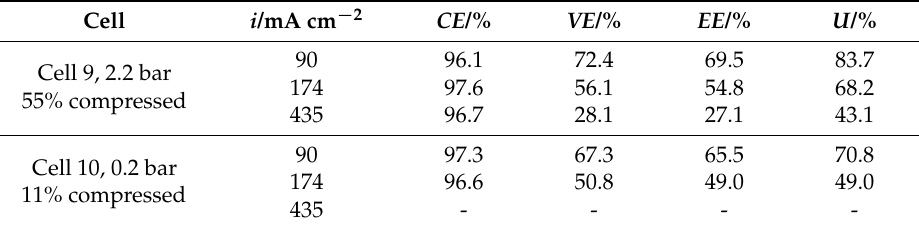
Table 3. Analysis of charge-discharge cycling for Cells 9 and 10.